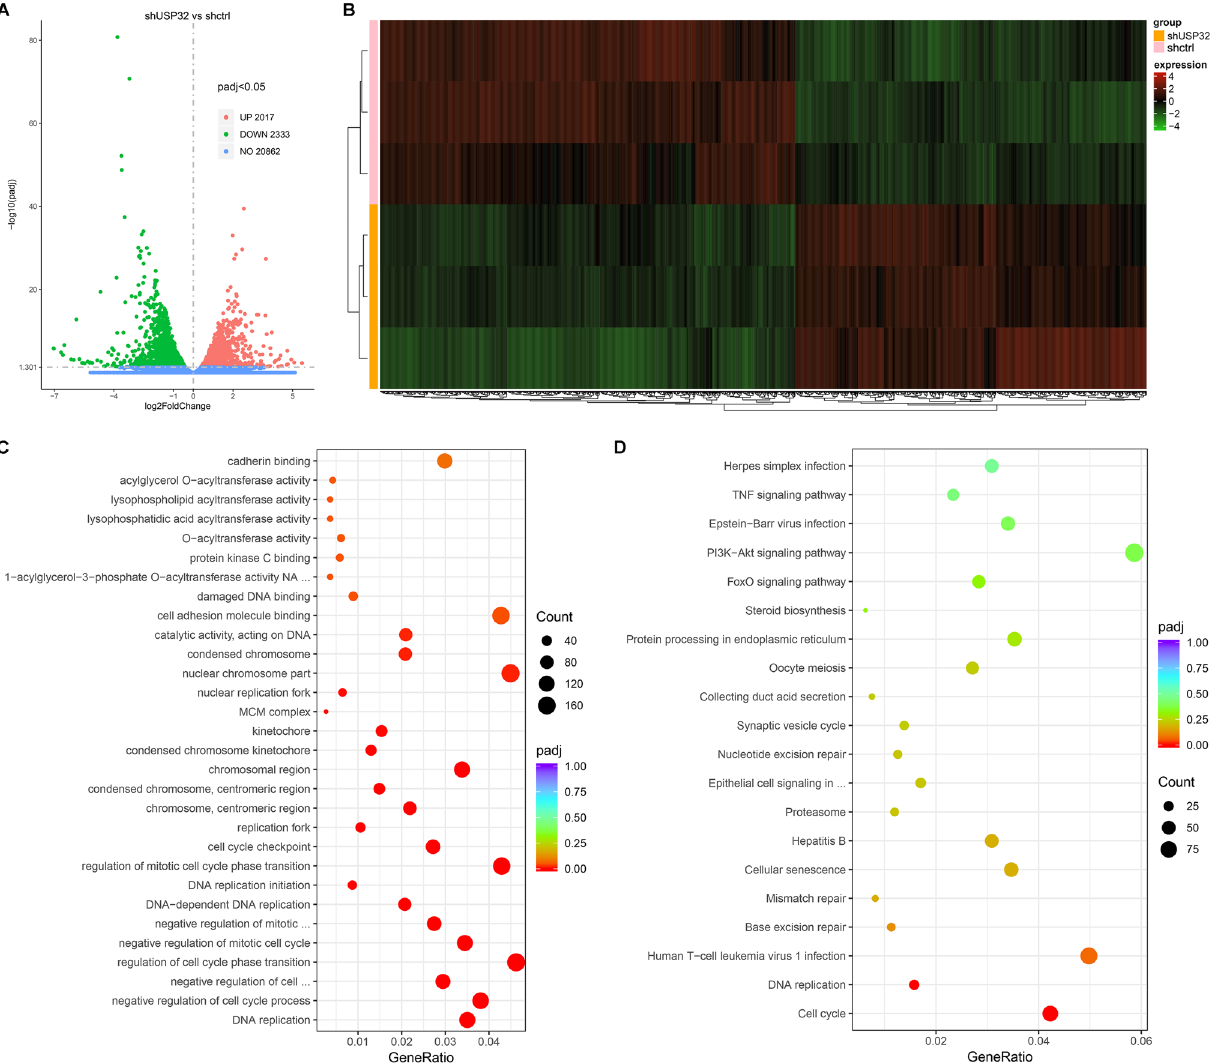
Figure 6. Gene Ontology (GO) and Kyoto Encyclopedia of Genes and Genomic (KEGG) pathway enrichment analyses using differentially expressive genes (DEGs) screened out by transcriptional sequencing. ( A ) Volcano plot based on the results of RNA sequencing for transcriptomes from shctrl and shUSP32 U87-MG cells. ( B ) The heat map showing the distinguishable mRNA expression patterns between the shUSP32 and shctrl samples. ( C ) GO enrichment analysis showing the considerable molecular functions, cellular components, and biological processes. ( D ) KEGG pathway enrichment analysis showing the considerable